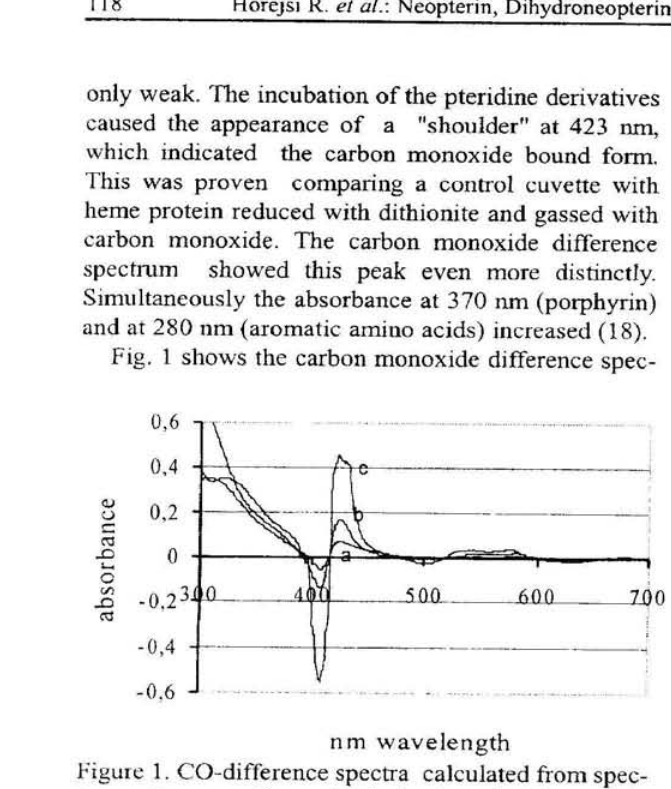
Figure 1. CO -difference spectra calculated from spec- troscopic scans of myoglobin incubated with neoptein (a), 7,8-dihydroneopterin (b) and 5,6,7,8-tetrahydro- neopterin (c). The peaks are identified as CO-adducts. tra from metmyoglobin with 160 μΜ neopterin, 7,8- dihydroneopterin and 5,6,7,8-tetrahydroneopterin. The peak at 423 nm is highest in the presence of tetrahy- droneopterin, followed by dihydroneopterin and it is weakest at the assay with neopterin.